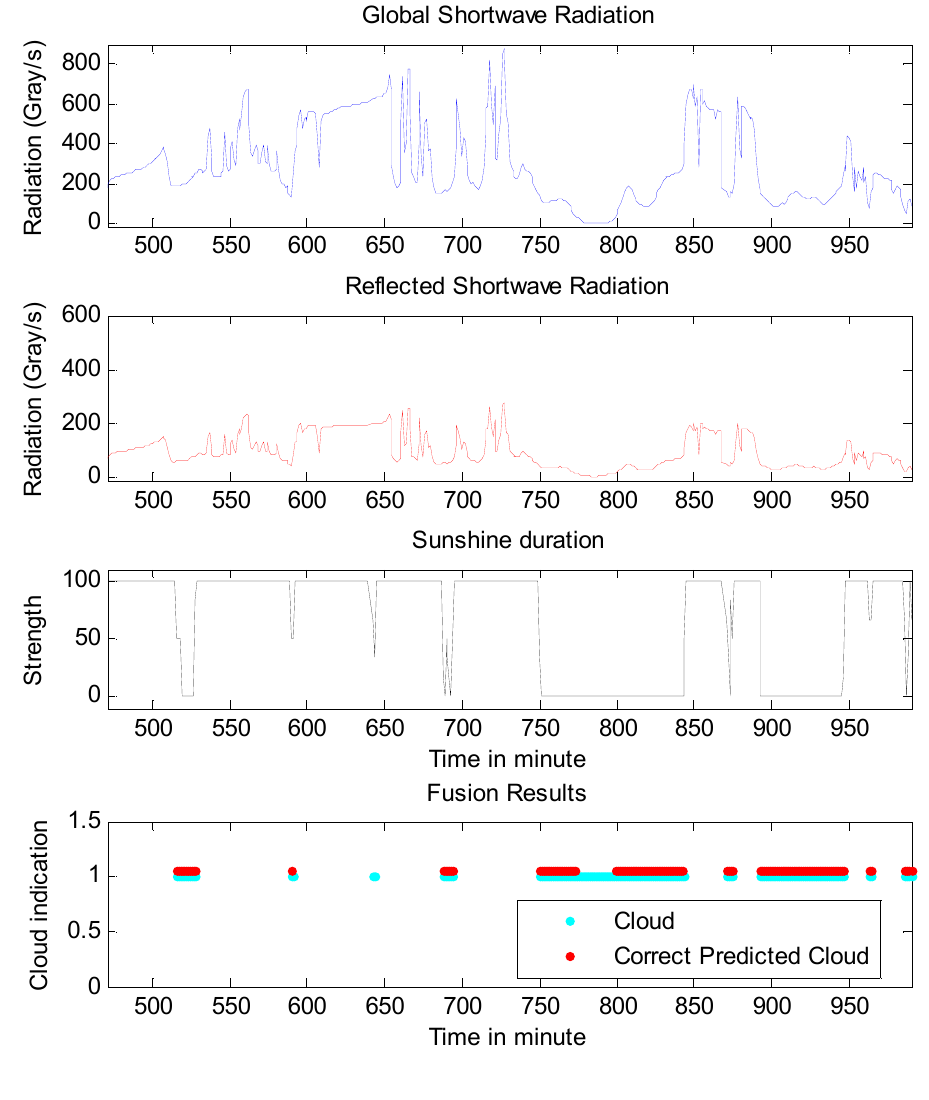
Figure 3. The comparison of the real cloud presence and the predicted cloud presence in a period, along with related sensor data on 13th of